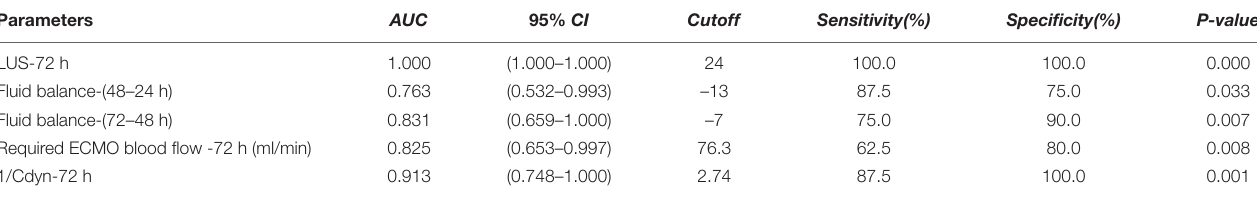
FIGURE 3 | Scatterplots demonstrating the correlation between LUS score and daily fluid balance volume (A) and Cdyn (B) . TABLE 3 | Receiver operating characteristic analysis of variables for predicting PICU